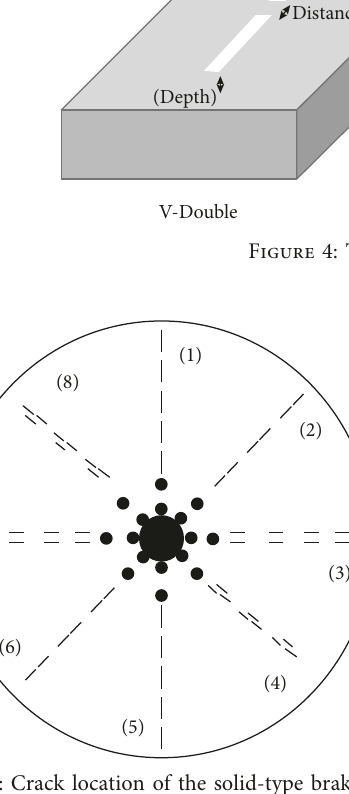
Figure 5: Crack location of the solid-type brake disc.